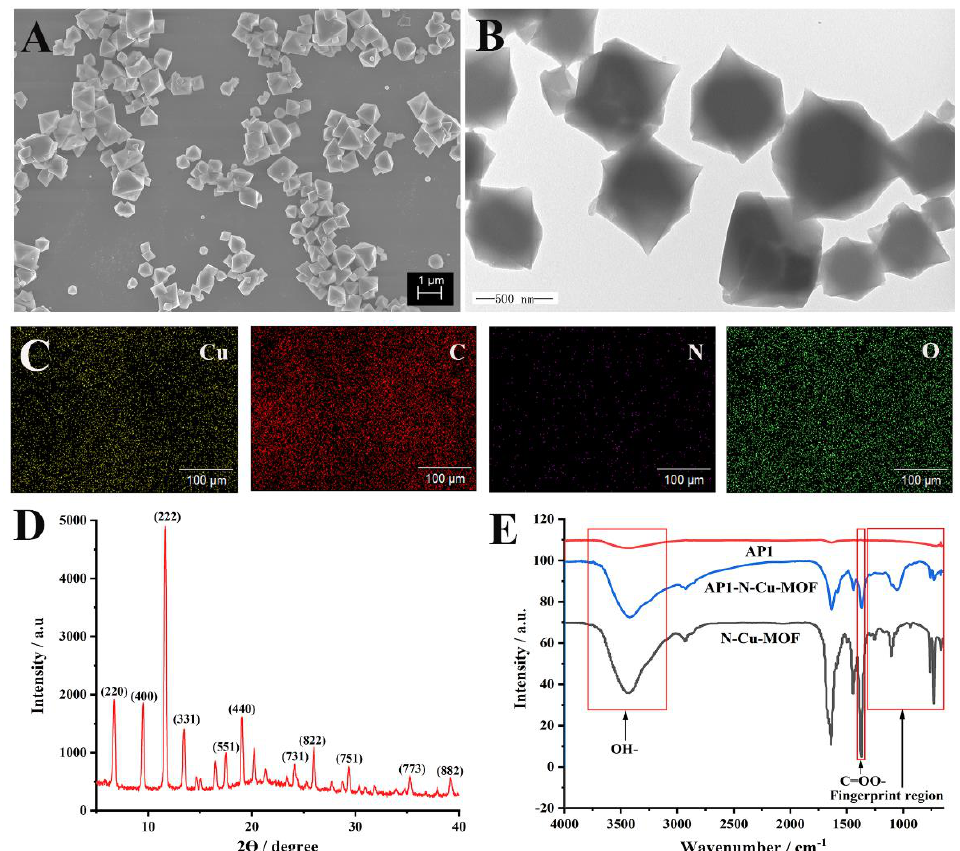
Figure 2. ( A ) Scanning electron microscopy image (SEM), ( B ) transmission electron microscopy image (TEM), ( C ) elemental mapping and ( D ) X-ray diffraction patterns (XRD) of N–Cu–MOF; ( E ) Fourier-transform infrared spectroscopy (FT-IR) spectra of N–Cu–MOF, aptamer (AP1) and